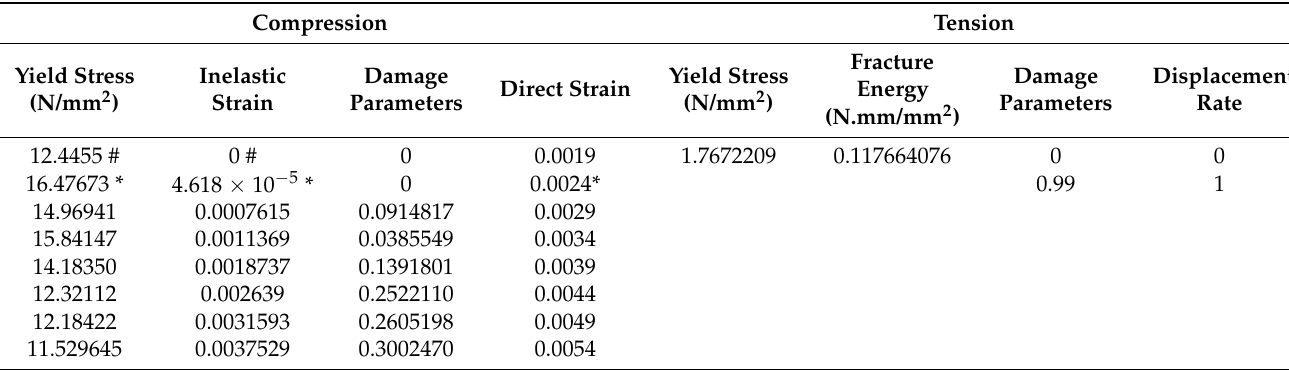
Table A4. Concrete compression and tension damage data for the MC-2.